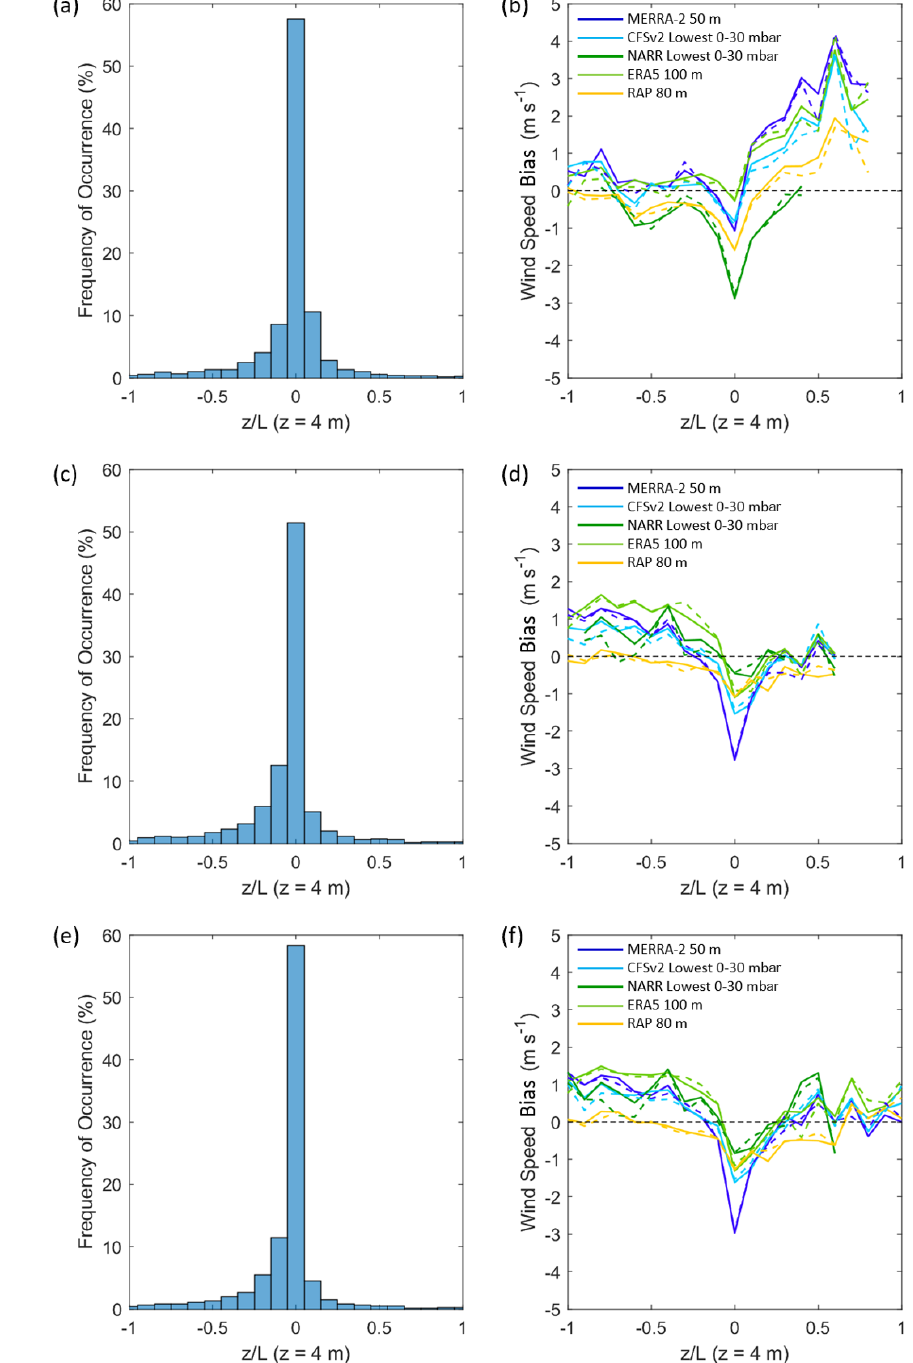
Figure 8. Distributions of stability parameter z/L during (a) the Humboldt deployment, (c) the Morro Bay deployment during the Humboldt overlapping period, and (e) the Morro Bay deployment during the full seasonal cycle. Average (solid) and median (dashed) rotor-level wind speed bias according to z/L during (b) the Humboldt deployment, (d) the Morro Bay deployment during the Humboldt overlapping period, and (f) the Morro Bay deployment during the full seasonal cycle, calculated over z/L intervals of length 0.1. Intervals with less than 10 samples are